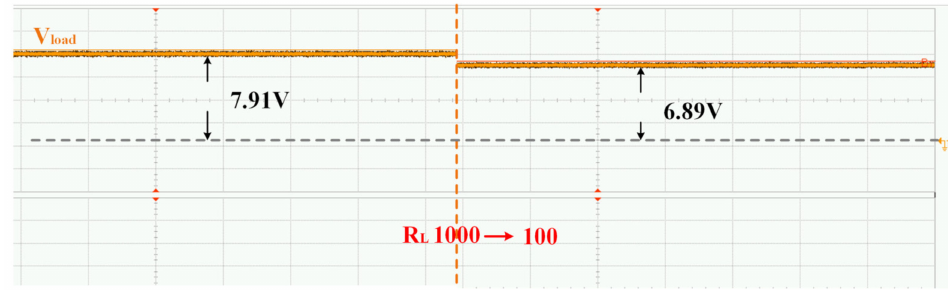
Figure 38. The output voltage V Load of the system when the load is suddenly